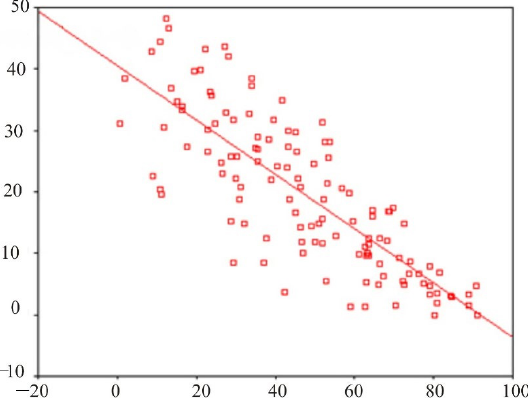
Figure 7. Scatter diagram of the direct regression illustrating the relationship between the EEG indices in site O 1 –T 3 in the delta and alpha ranges.